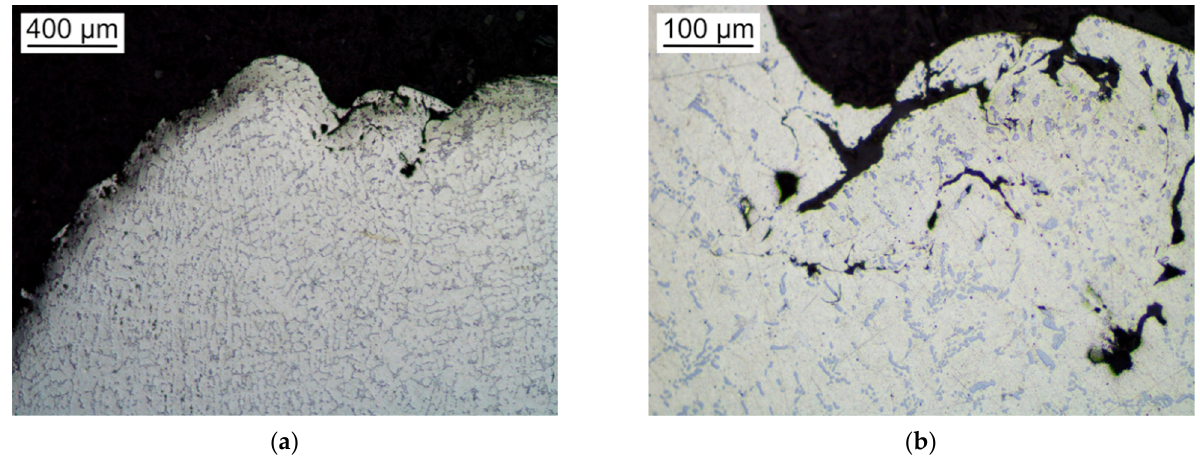
Figure 6. Metallographic features on the longitudinal section of the crept sample E3 in optical micrograph at low- ( a ) and high-magnification ( b ) clearly displaying the eutectic regions, the material deformation in vertical direction and the presence of discontinuities.